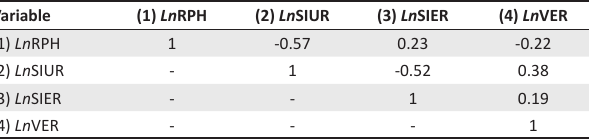
TABLE 2: Pearson correlation coefficients ( N = 115); major code 72 (digits 721, 722 and 723). Variable